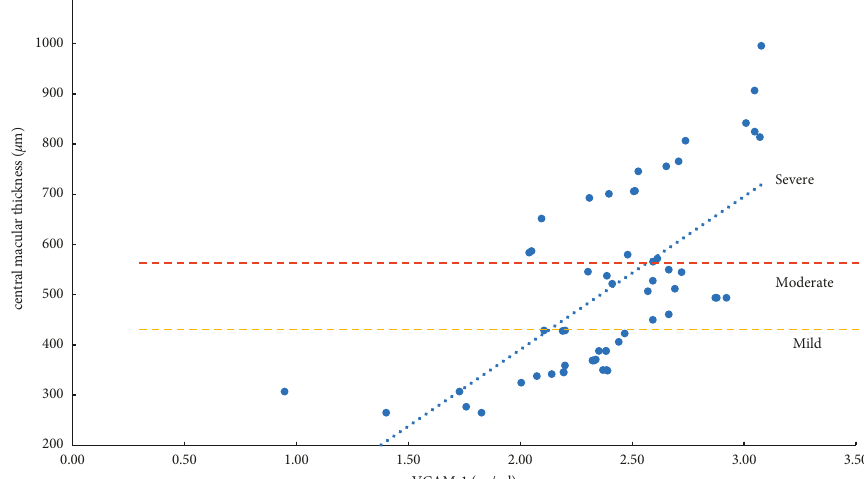
Figure 4: Correlation analysis of ME with a mild, moderate, and severe degree and VCAM-1 (vascular cell adhesion